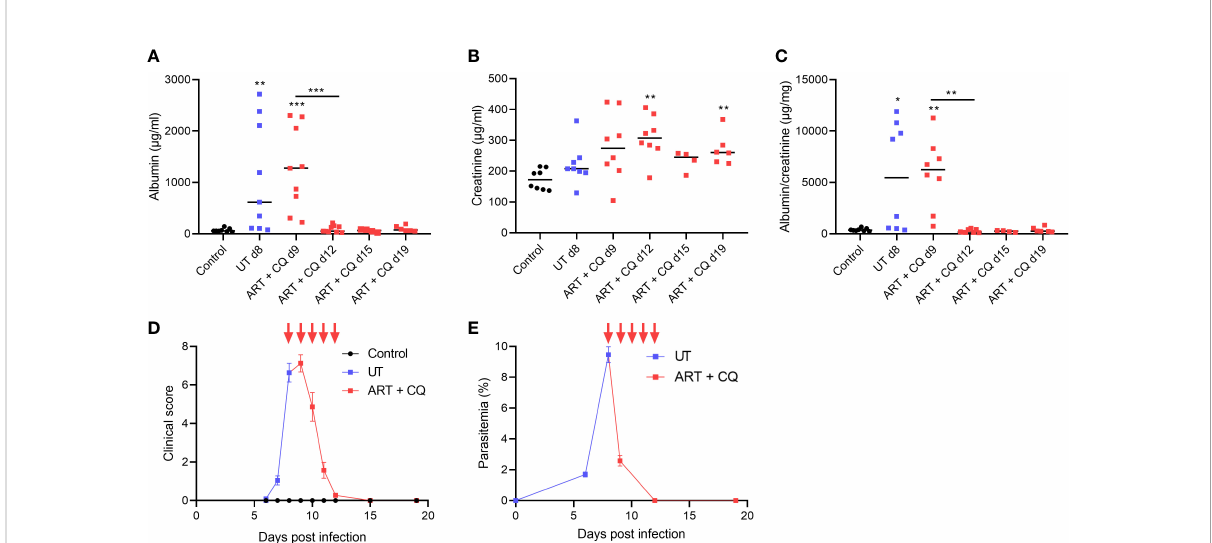
FIGURE 1 Antimalarial treatment decreased proteinuria in Pb NK65-E infected mice. C57BL/6 mice were infected with Pb NK65-E and were treated daily from day 8 until day 12 p.i. with 10 mg/kg ART + 30 mg/kg CQ (ART+CQ). (A – C) Albumin, creatinine and albumin/creatinine ratios in the urine were determined. (D) The clinical score was monitored daily from day 6 p.i. onwards, daily ART + CQ treatment indicated with red arrows. (E) Peripheral parasitemia was determined on blood smears, daily ART + CQ treatment indicated with red arrows. Asterisks above data points indicate signi fi cant differences compared to control mice, asterisks above a horizontal line show signi fi cant differences between different time points, *p < 0.05, **p < 0.01, ***p < 0.001. (A – C) Data of two experiments, Control: n = 8, untreated Pb NK65-E infected mice (UT) d8: n = 8-9, ART+CQ d9-d19: n = 4-9. (D, E) Data of two experiments, Control: n = 6, UT/ART+CQ: n = 6-22. Mann-Whitney U test with Holm-Bonferroni correction for multiple testing (number of tests = 6) was